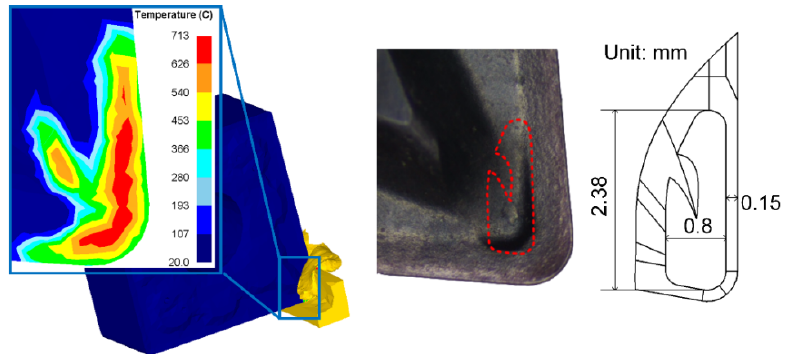
Figure 1. Shape of micro-groove tool and geometric dimensions.